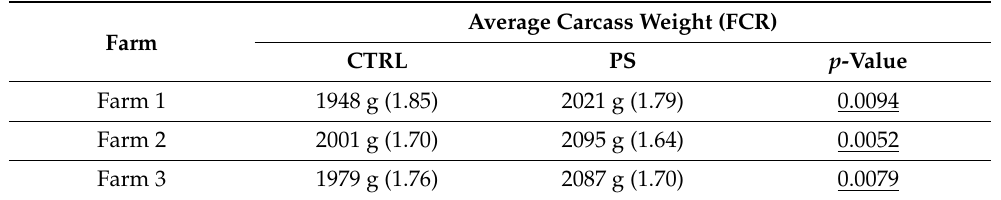
Table 3. Average carcass weights and feed conversion ratios (FCRs) measured in treated and control houses of the three farms. p -values below 0.05, marking the statistical significance of a difference observed when comparing treatment and control groups, are